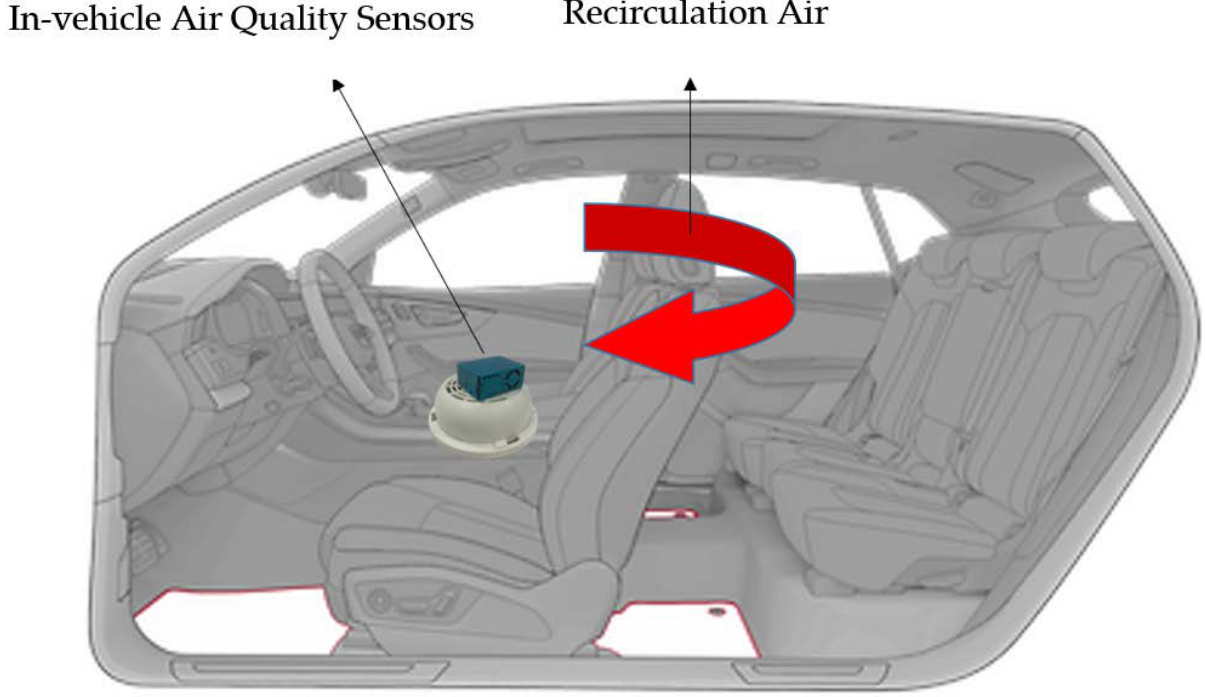
Figure 4. Representation of Sensor Device in Vehicle Cabin.